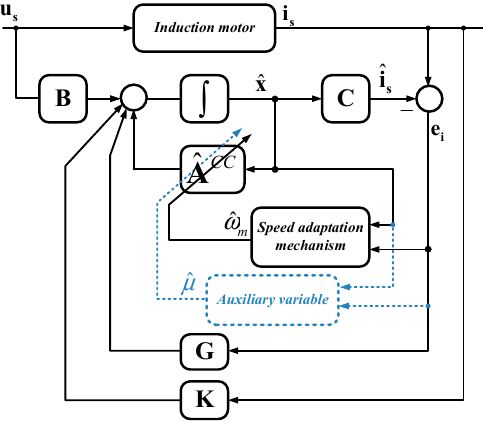
CC with all stability improvement